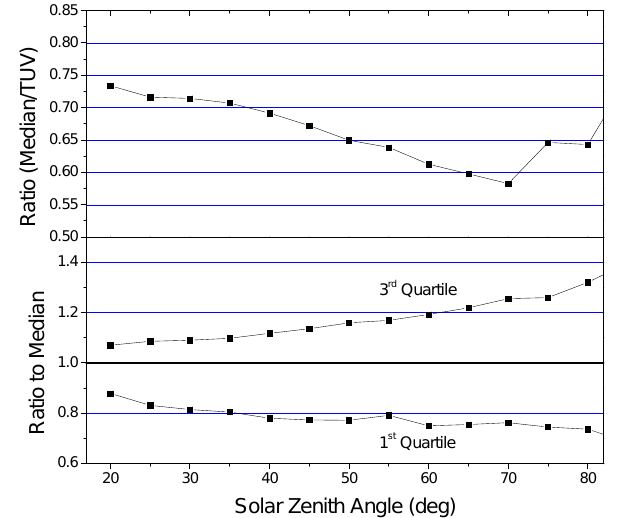
Figure 7. Top panel shows the ratio of the median measured J (O 1 D) to that from a calculation for clear skies. The bottom panel shows the spread in quartile values as a ratio to the